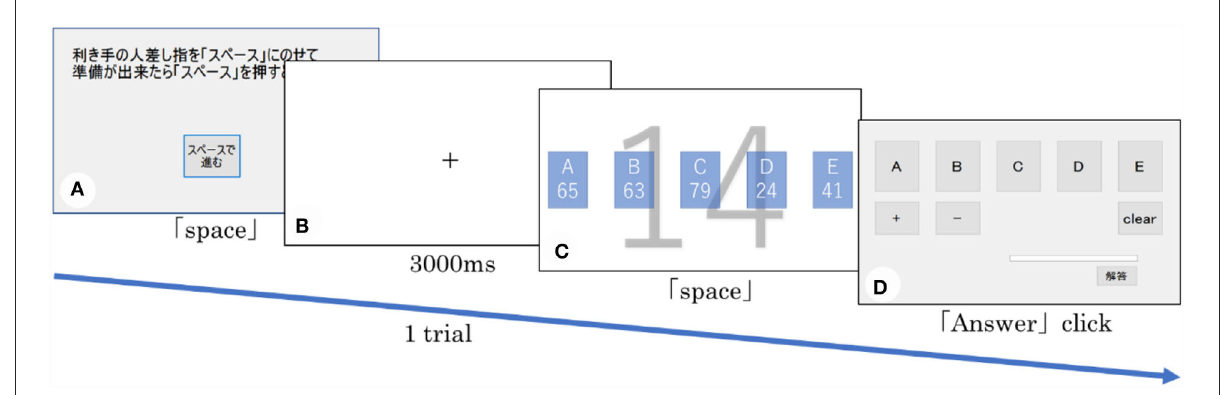
FIGURE2 The task flow. (A) , (C) , and (D) are presented in the preparation, thought, and reporting phases, respectively. In (B) , the fixation point was presented in the center of the